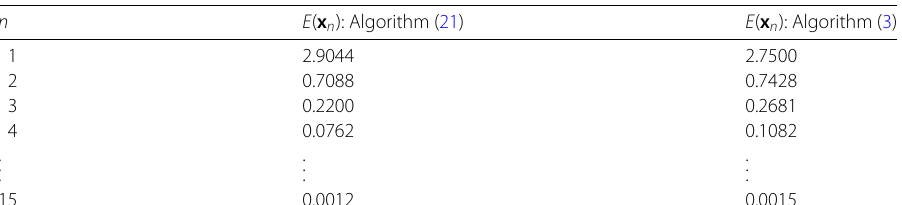
Table 3 Detailed analysis of computational methods (21) and (3) for Example 1 with u = 3, N = 15 and E ( x n ) = (cid:4) x n +1 – x n (cid:4) , n ∈ N 0